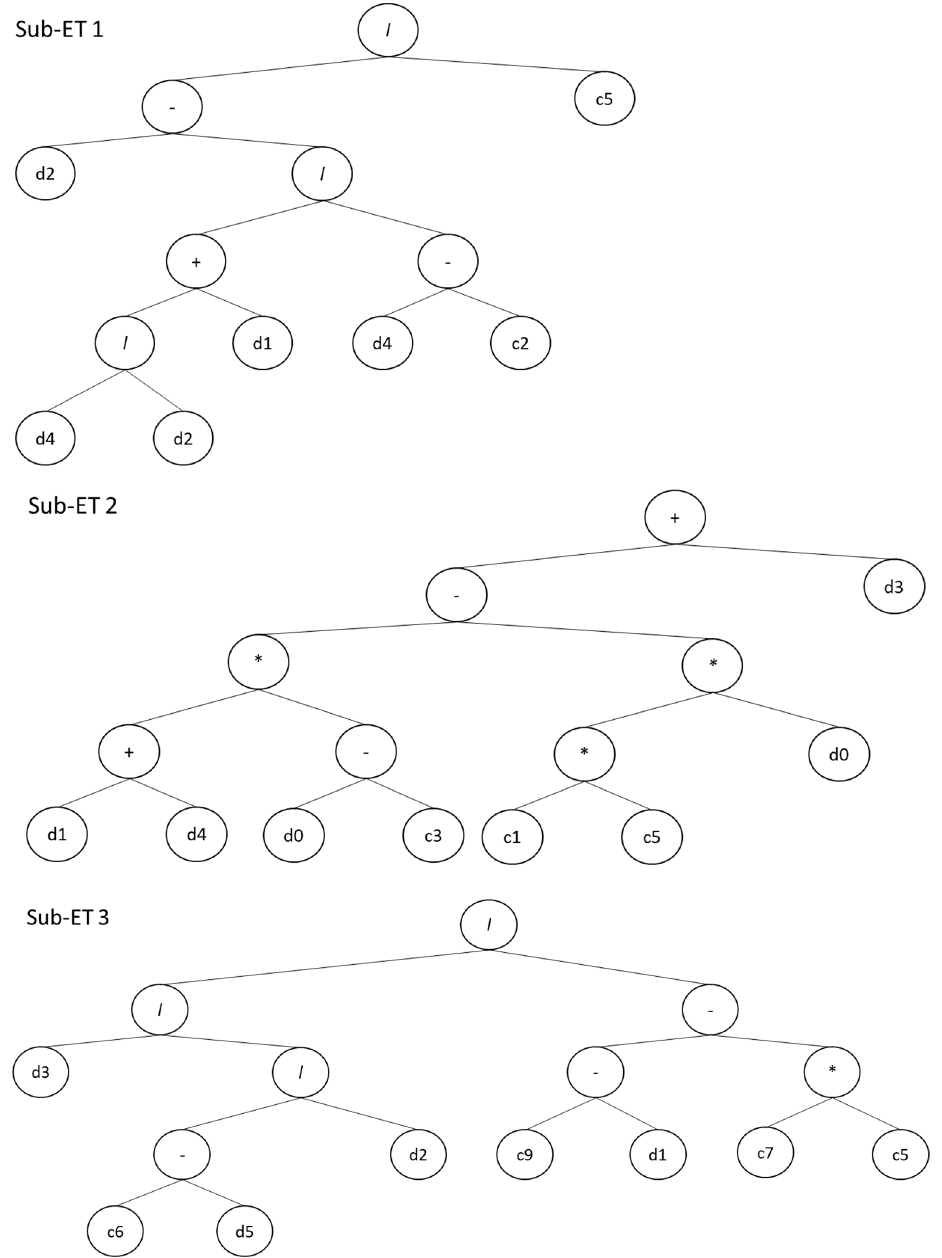
( f ) Figure 8. ( a ) Predictions vs. target data of training set; ( b ) error distribution of SVM model with prediction versus training set; ( c ) predictions vs. target data of validation set; ( d ) error distribution of SVM model with prediction versus validation set; ( e ) predictions vs. target data of testing set; ( f ) error distribution of SVM model with prediction versus testing set. 5.3. Gene Expression Programming The output of the GEP algorithm for the SCC model is denoted as an expression tree(s), as illustrated in Figure 9. The GEP algorithm solves nonlinear expressions as well